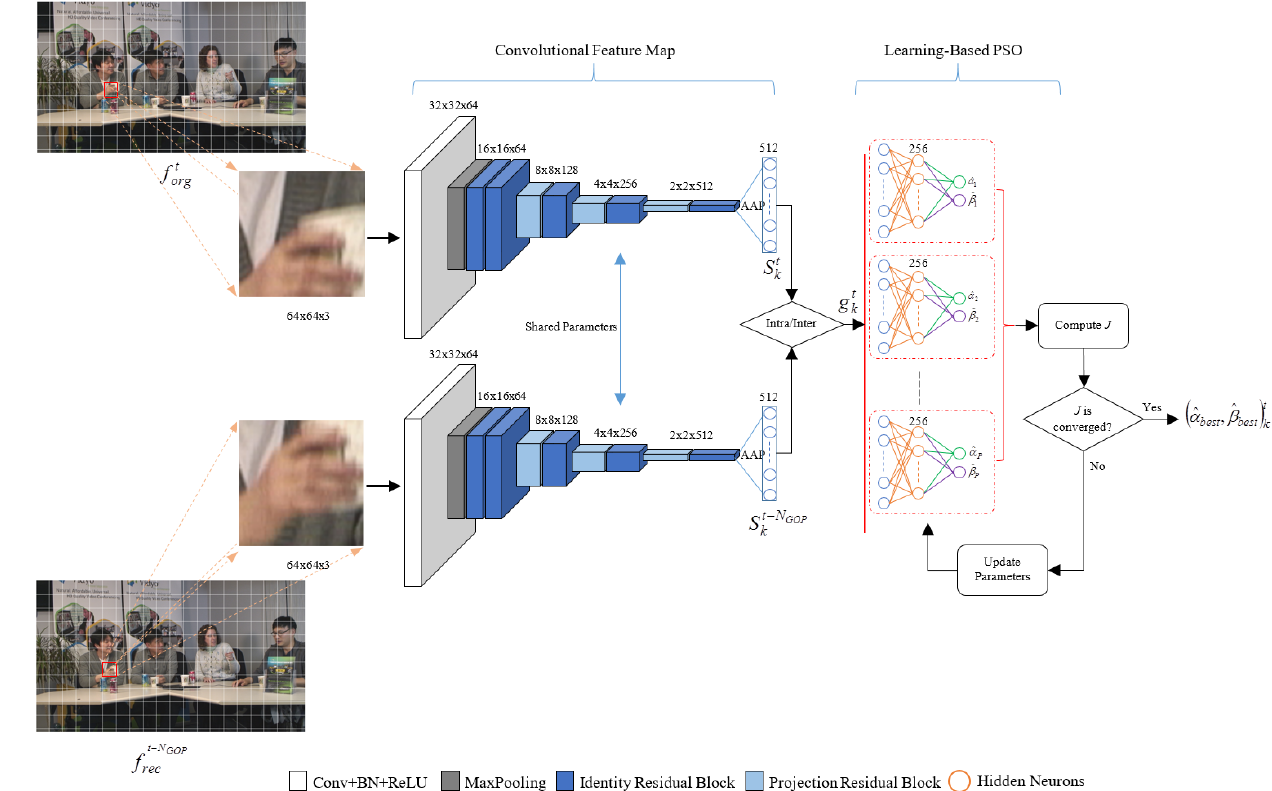
Figure 2. Overview of proposed learning-based particle swarm